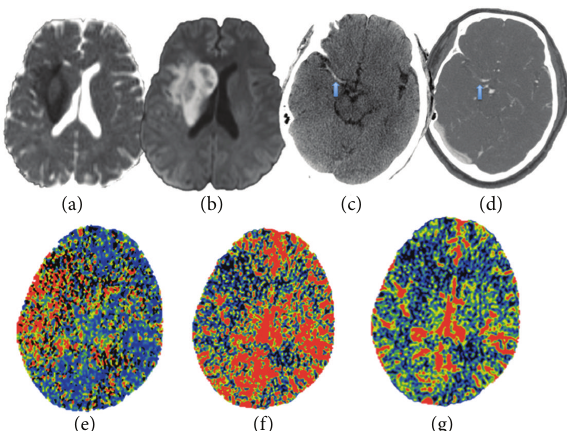
Figure 2: (a) and (b) ADC map and DWI map with restricted diffusion in the setting of cytotoxic edema from acute ischemic infarct in right MCA territory. (c) NECT showing hyperdense right MCA compatible with acute thrombosis. (d) CTA image with thrombosis in the corresponding segment of right MCA. (e), (f), and (g) CTP with elevated MTT, reduced cerebral blood flow, and blood volume in the right MCA